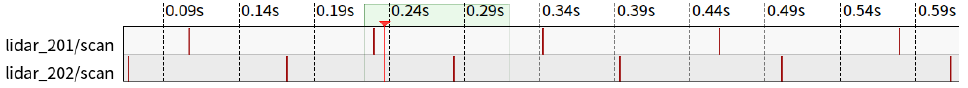
Figure 4. Timestamps of dual lidar.